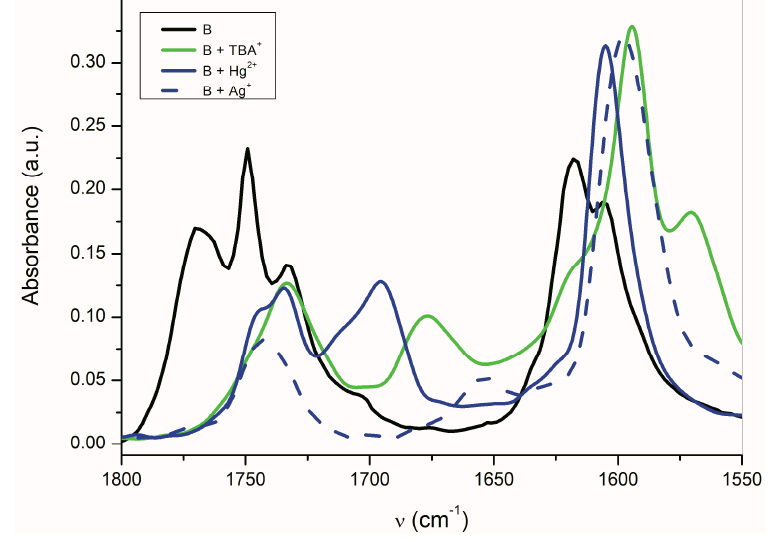
Figure 7. Effect of the counter ion on the B -azanion FTIR spectrum (ATR).